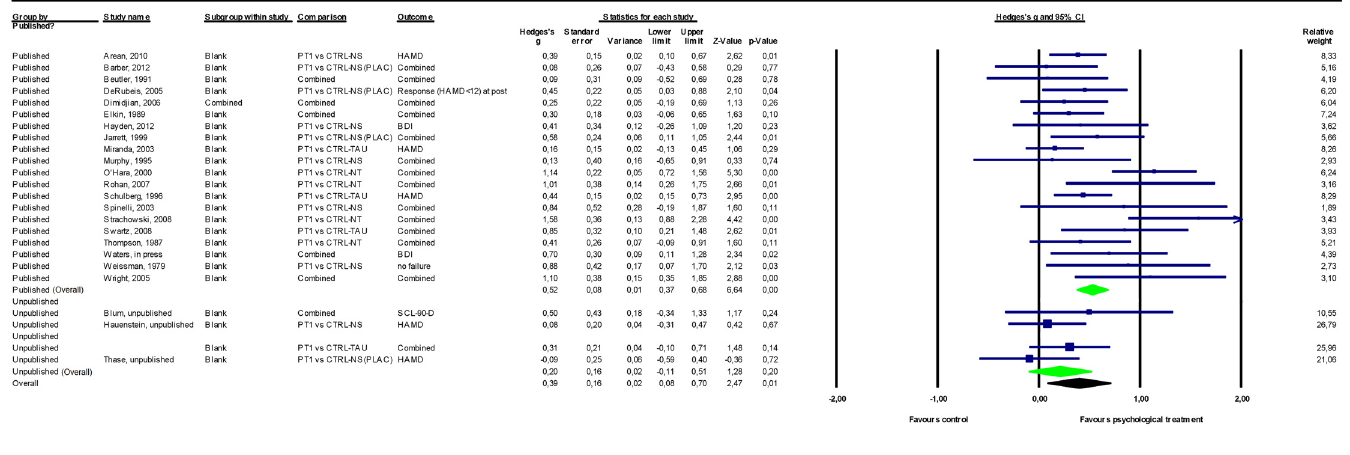
Fig 2. Psychological treatment versus control conditions (all). Note: Not all results of the unpublished studies are presented at study level, because we did not have permission of the investigators to do so. BDI = Beck Depression Inventory; CTRL-NS = non-specific control condition (psychological placebo); CTRL-NS(PLAC) = pill-placebo control condition; CTRL-NT = no-treatment control condition; CTRL-TAU = treatment as usual control condition; HAMD = Hamilton Depression Rating Scale; PT = psychological treatment; SCL-90-D = Symptom Checklist — 90 item, depression subscale.